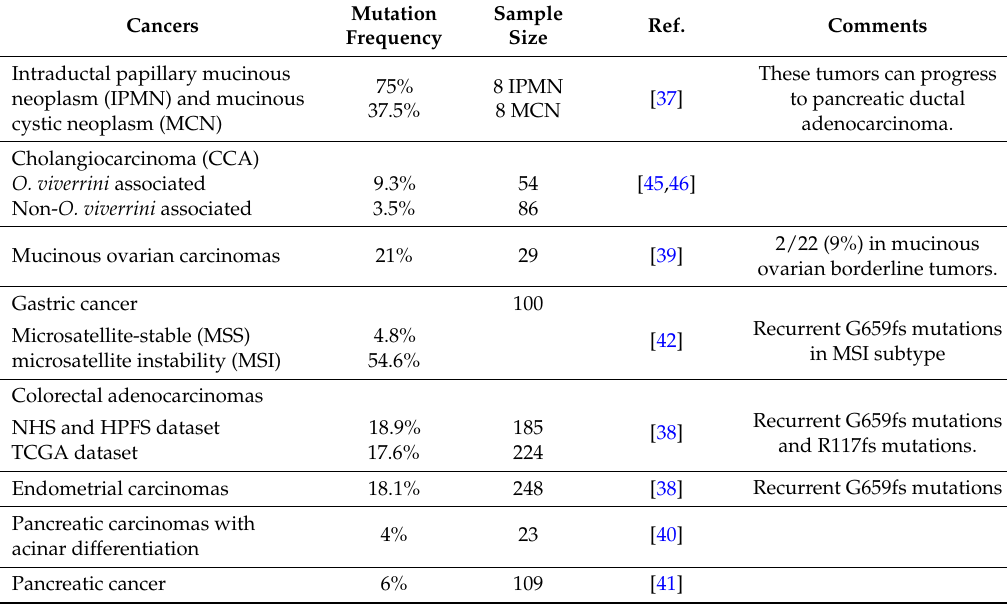
Table 1. RNF43 mutations in different cancer